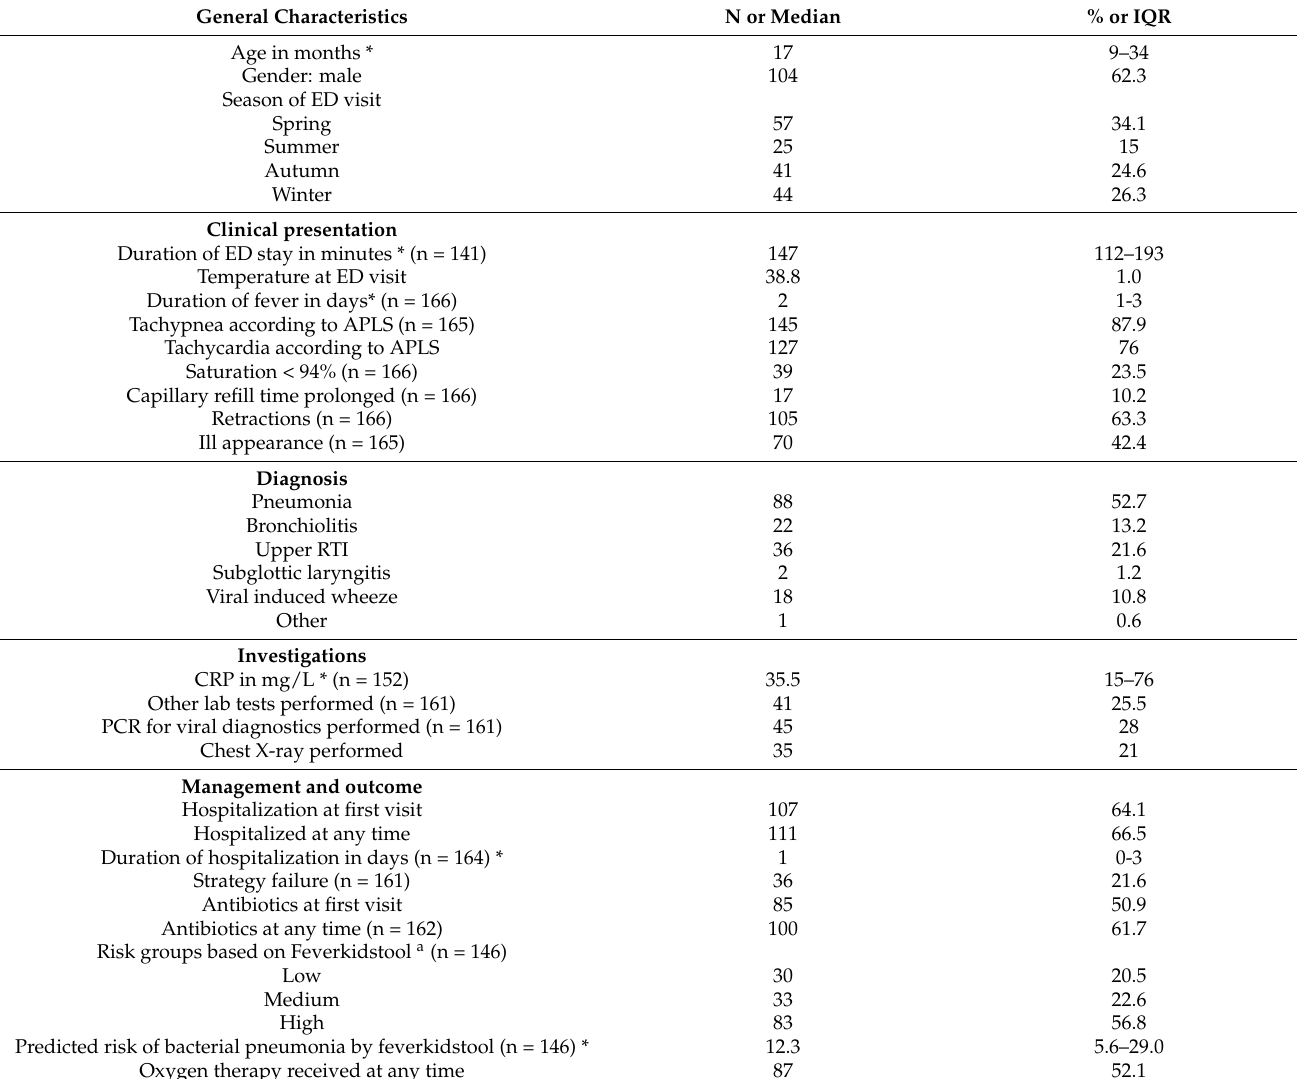
Table 1. Baseline characteristics and management of the study population (n =